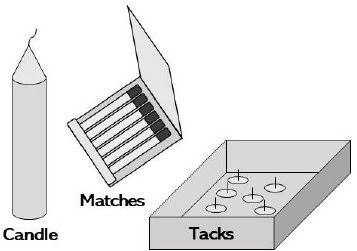
Figure 3. Duncker